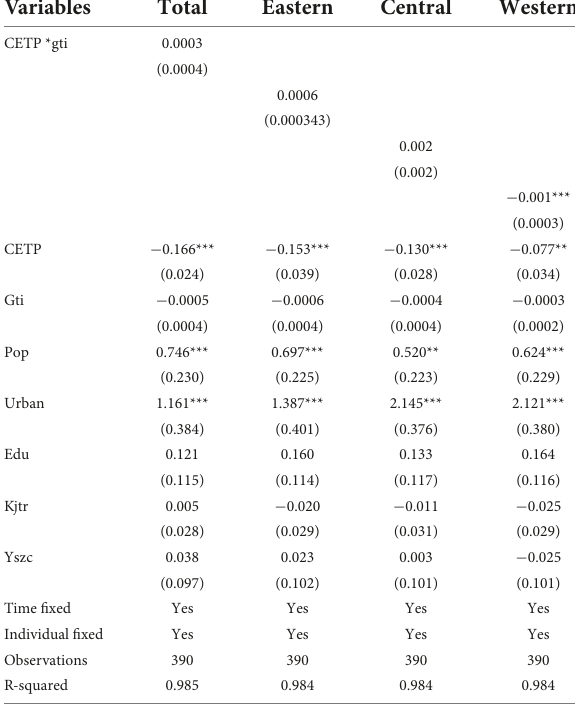
TABLE 7 Green technology innovation interaction results.